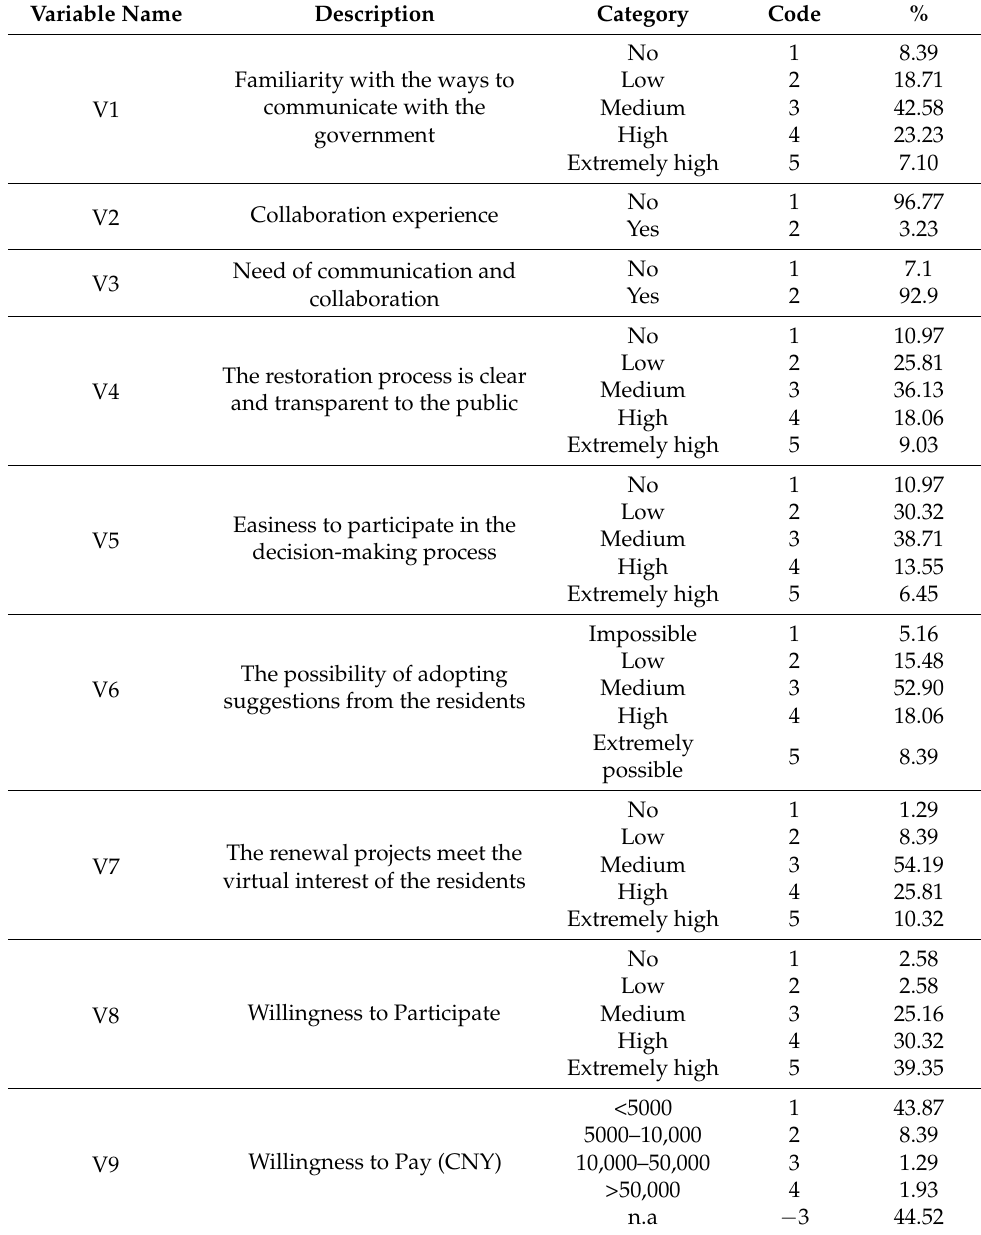
Table 8. The assessment framework of the Willingness to Participate and Willingness to Pay (made by